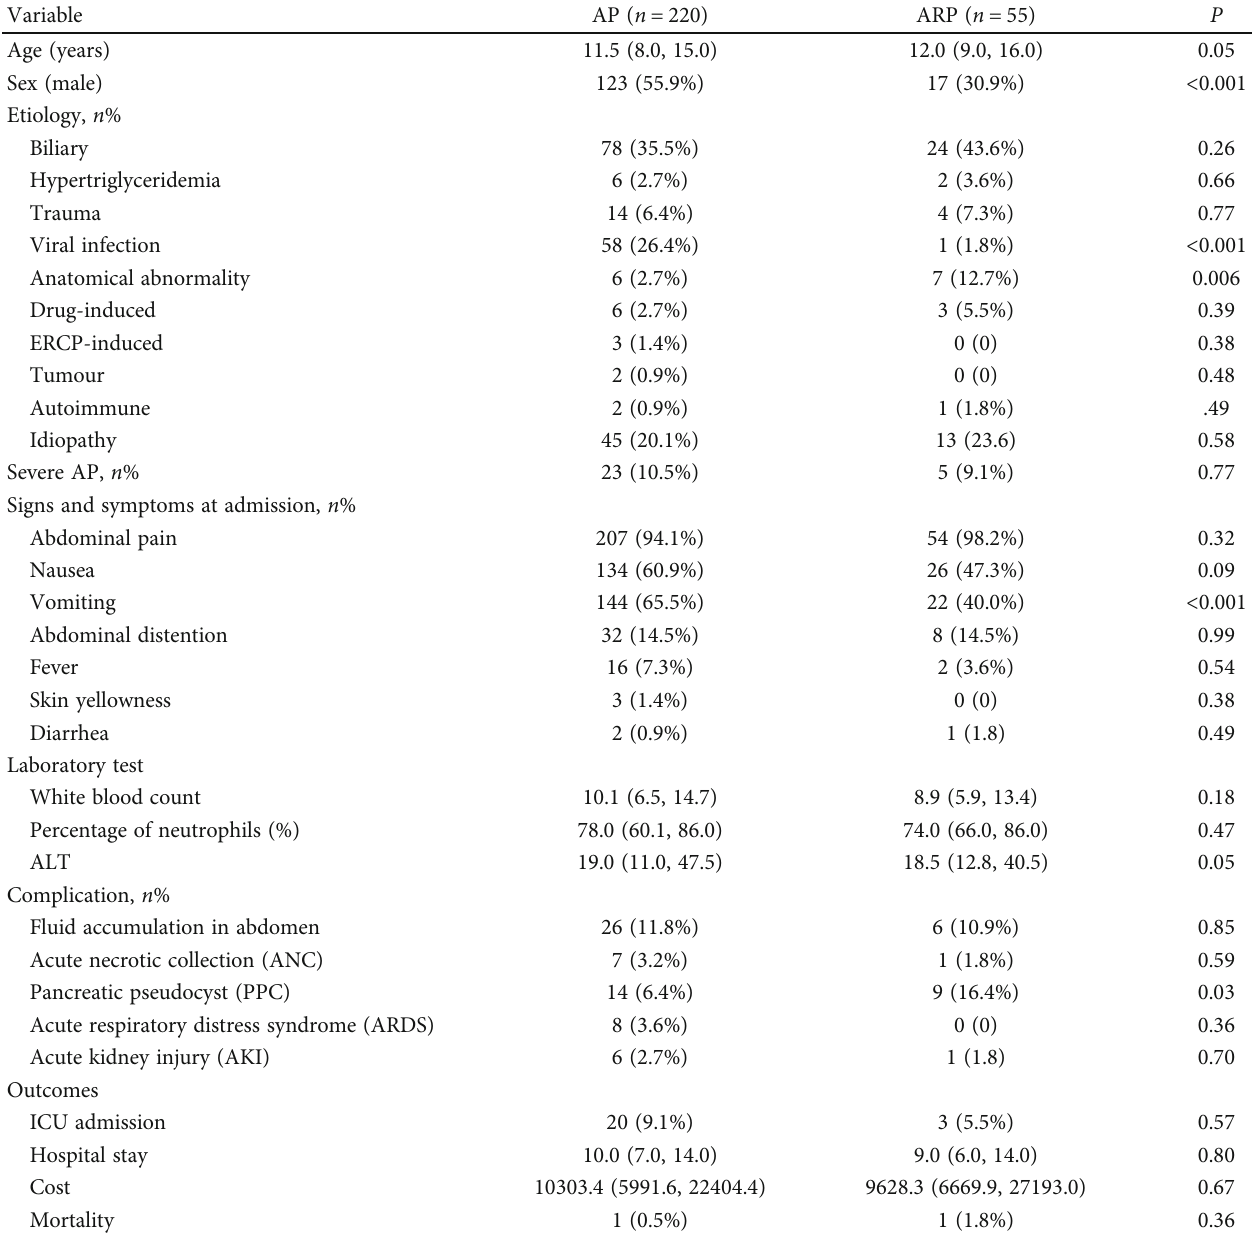
Table 1: Clinical characteristics and outcomes of AP and ARP.